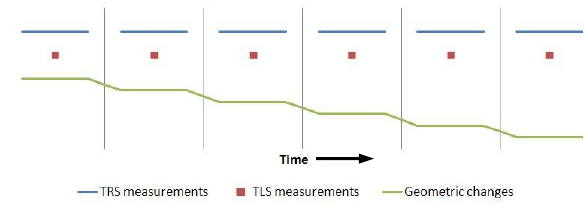
Figure 3: Measurement plan of the experiment - TRS measurements (blue line), TLS measurements (red squares) and geometric changes (green line) The slope has been scanned in every epoch with a point spacing of 20 mm at 45 m which means that areas that are further away are subject of coarser sampling and vice versa. Figure 4 illustrates the outcome of a deformation analysis [m] between the first and the last epoch derived from TLS measurements.